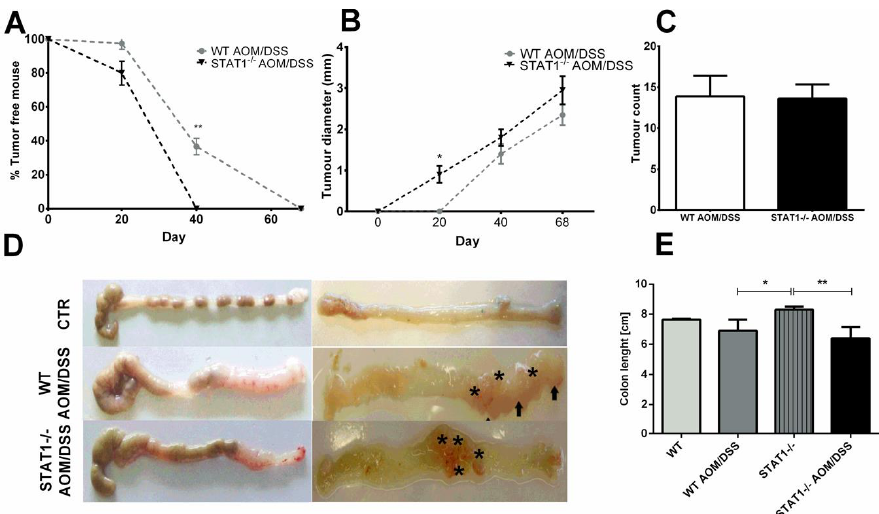
Figure 2. STAT1 deficiency leads to rapid development of CAC. Colons were removed and the number of macroscopic tumors were determined at the indicated time intervals. ( A ) Time course of the percentage of tumor-free mice during the AOM/DSS treatment in WT and STAT1 − / − mice. ( B ) Tumor diameter (mm) of colorectal tumors formed in WT AOM/DSS and STAT1 − / − AOM/DSS animals at the indicated times. ( C ) Number of colorectal tumors per mouse 68 days after AOM administration. ( D ) Representative photographs of the colon 68 days after the AOM injection (asterisks and arrows point to the tumors). ( E ) AOM/DSS treated mice had significantly smaller colons than control mice. Total data ( A , B , C , E ) and representative data ( D ) of two independent experiments with at least three mice per group. Data are expressed as means ± SDs. Statistically significant differences between two groups were judged by the Student ’ s t -test. * p ≤ 0.05, ** p ≤ 0.01.